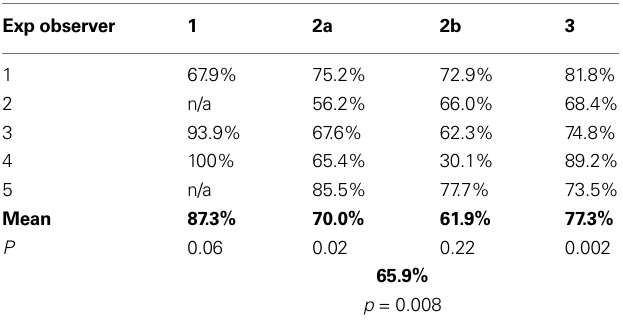
Table 2 | Trial-by-trial prediction for